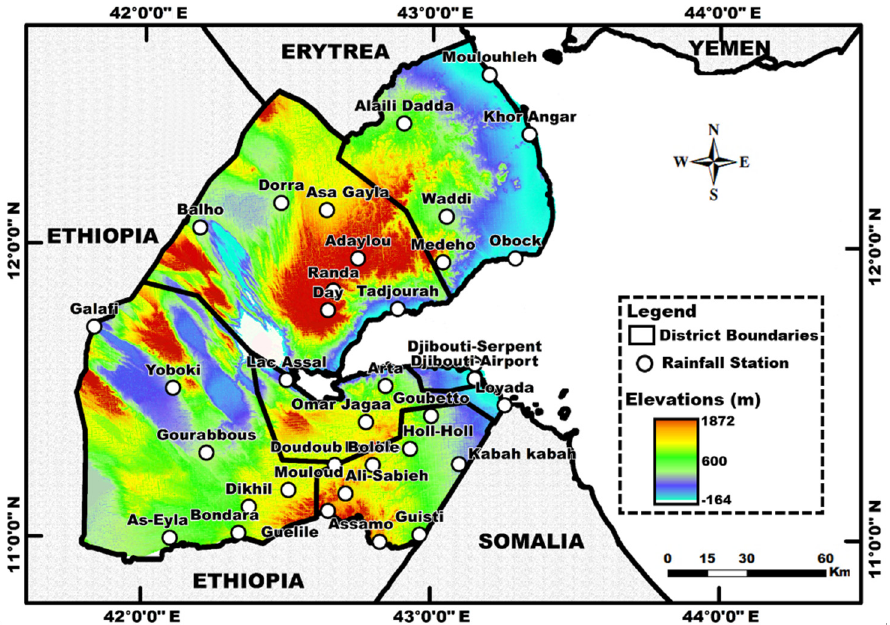
Figure 1. Map and spatial distribution of the meteorological stations and elevation. The white dots on the map represent the 35 meteorological stations across the country.